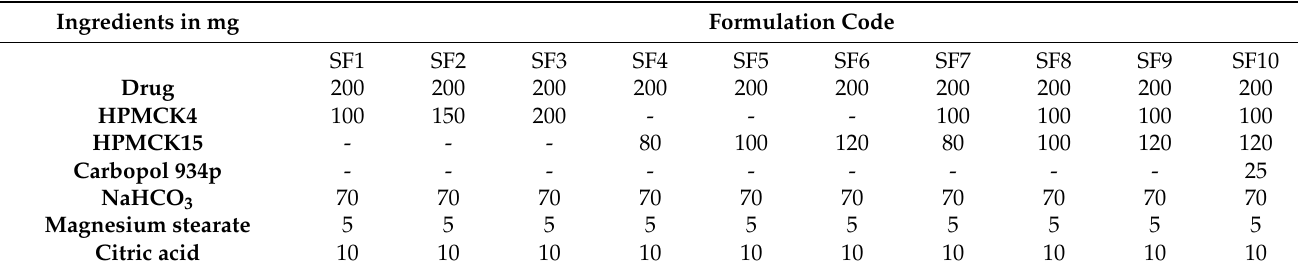
Table 7. Composition of optimized floating